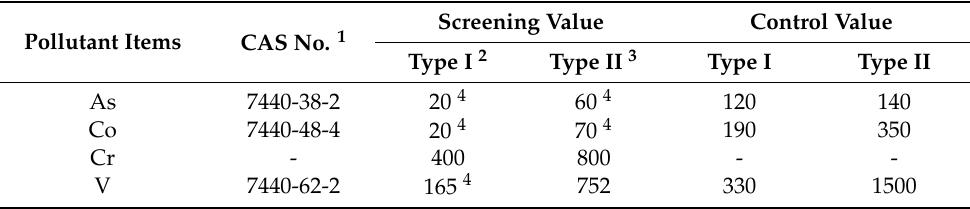
Table 4. Screening values and control values for the risk of heavy metal contamination of soil on construction land.